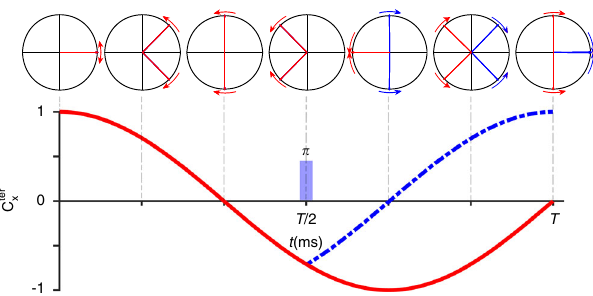
Fig. 3 Schematic explaining disappearance of isoleucine and leucine peaks when the constant-time duration is set to T = 3/(2 1 J CC ). The simulation shows the transverse projection of the 13 CH 3 Leu (red), Val (blue) magnetization vector, with arrows showing the sense of rotation with respect to the intrinsic chemical shift frequency. The resulting 13 CH 3 -x magnetization for Leu (red), Val (blue, dashed) are shown below. The constant-time evolution period T is set to 42 ms (3 / (2 1 J CC )). The shaped pulse at the T / 2 selectively decouples C γ Val from C β Val , resulting in the appearance of the valine peaks. The disappearance of isoleucine and leucine peaks in the spectrum is due to the cancelling out of the anti-phase term arising because of the 13 C – 13 C spin coupling. with constant-time T set as 1 / 1 J CC and 3 / (2 1 J CC ), respectively. The latter spectrum has only valine methyl peaks, enabling identi fi cation of any leucine-valine overlapping peaks. The theory explaining the disappearance of leucine methyls when T = 3 / (2 1 J CC ) is shown in Fig. 3.